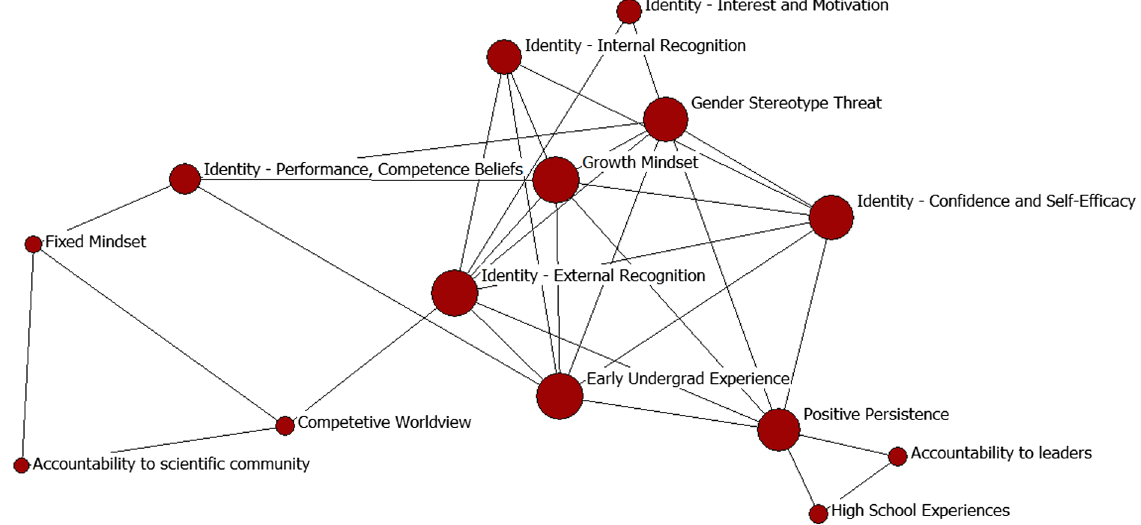
FIG. 2. Network map which shows the relationships between codes for female students at the p < 0 . 05